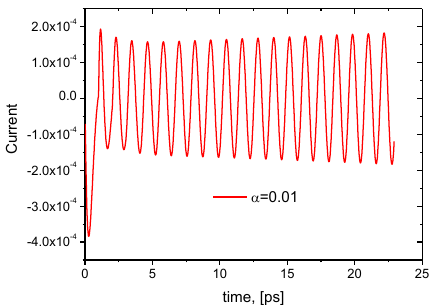
Fig. 3. The initial stage of current oscillations (a.u.) originating from fluctuations of density in the channel. Quite harmonic oscillations with slowly rising amplitude are visible.